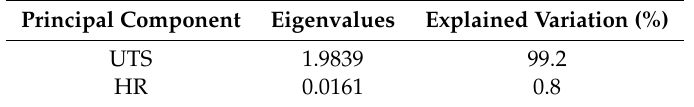
Table 12. Eigenvalues and explained variation for ultimate tensile strength and hardness.